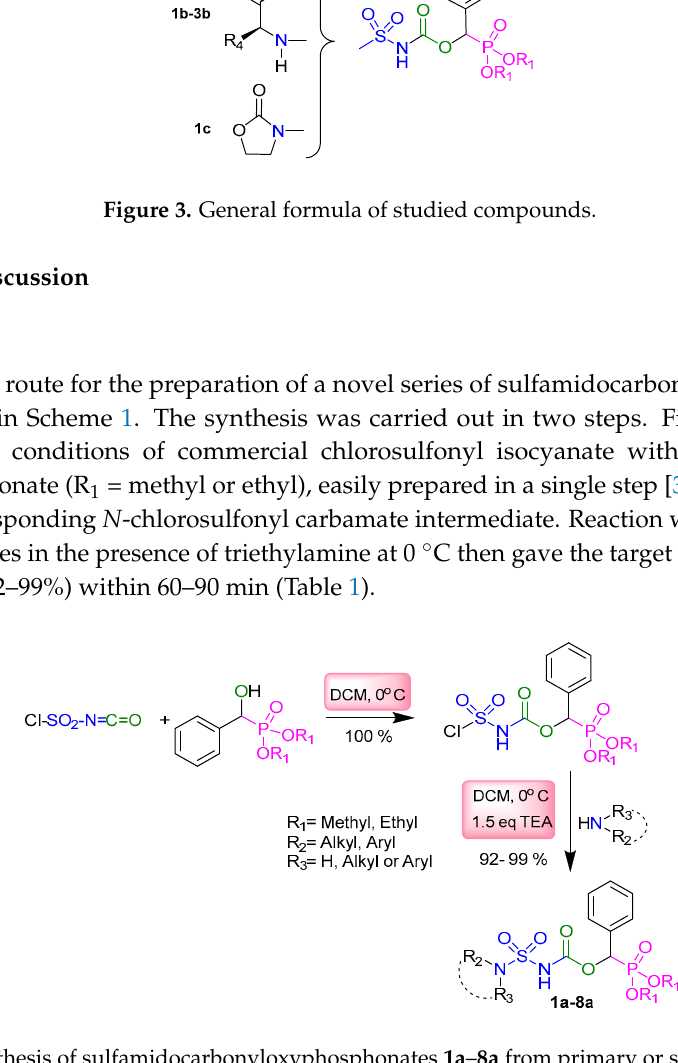
Figure 2. Structures of drugs approved for human use.